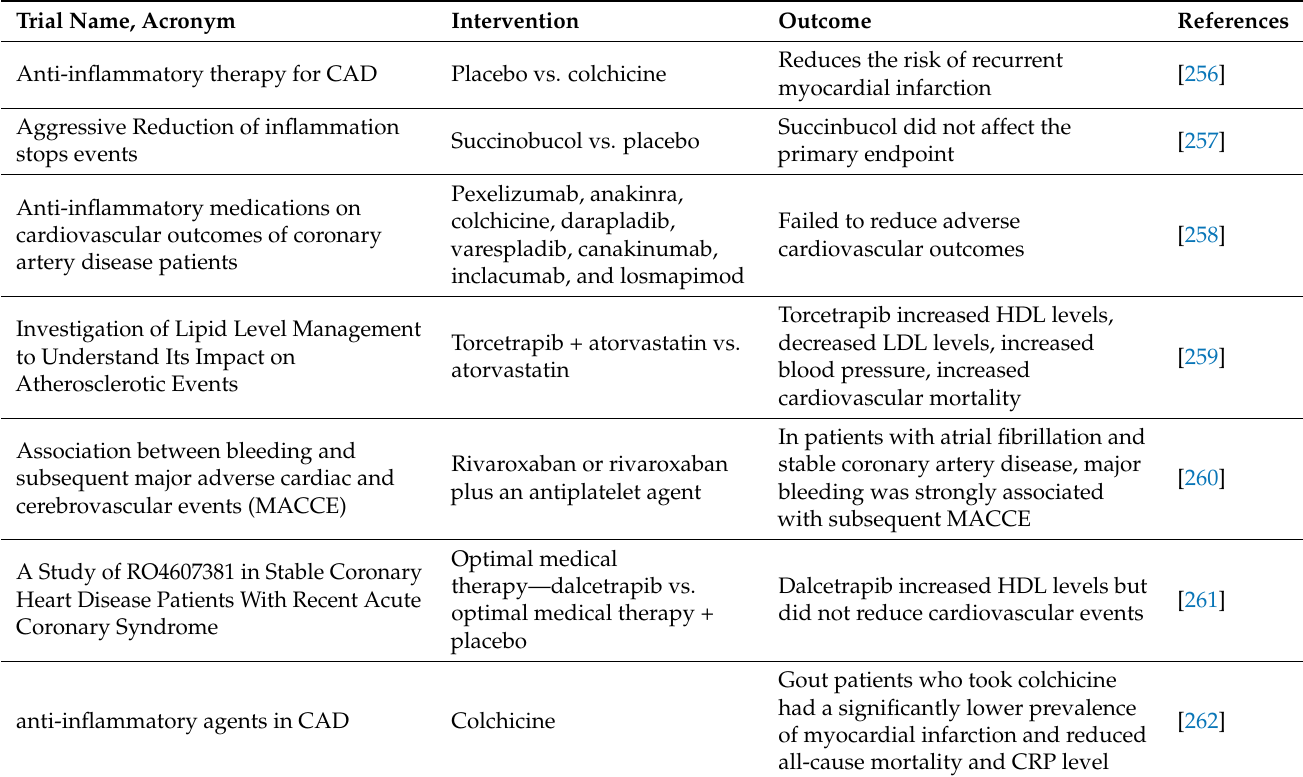
Table 5. Clinical trials in